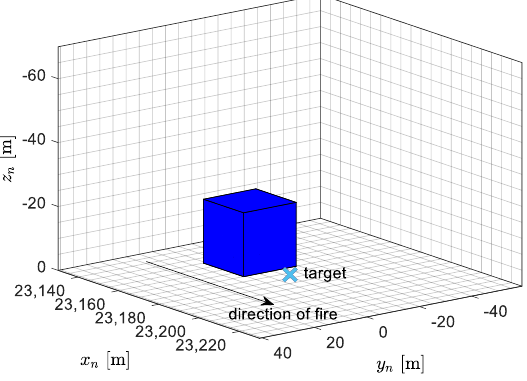
Figure 8. Simulation scenario with obstacle geometry for launch angle Θ 0 = 20 ◦ Figure 8 . Simulation scenario with obstacle geometry for launch angle 𝛩 0 = 20°